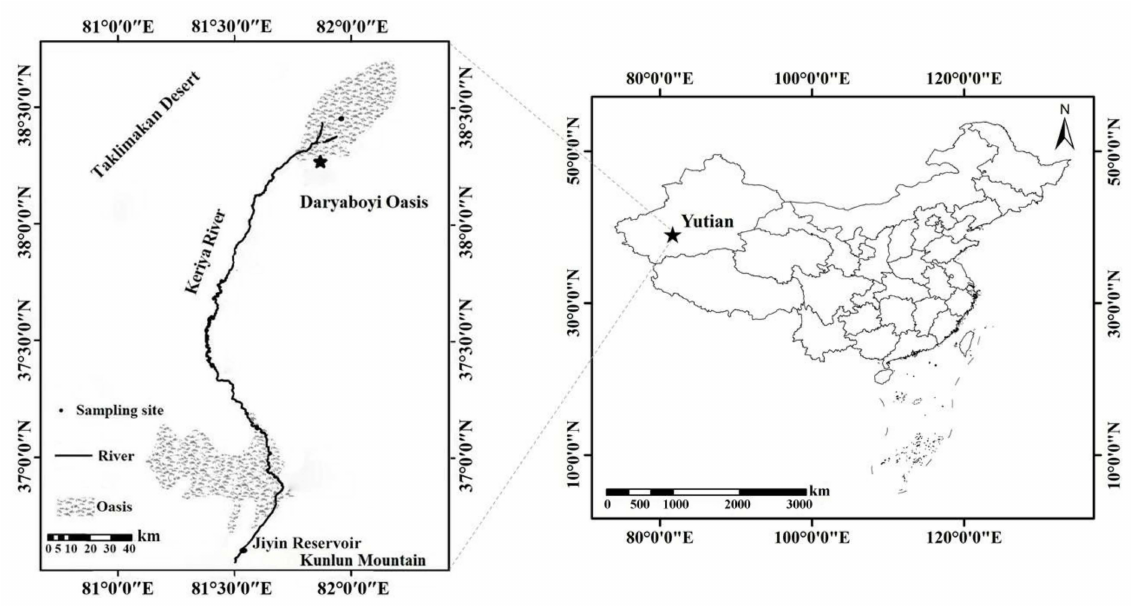
Figure 1. Location of the study